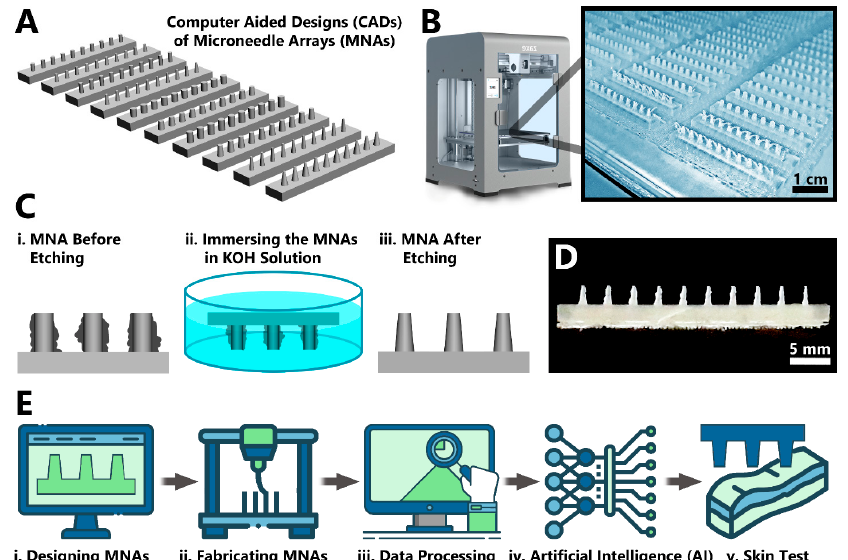
Figure 1. Fabrication of MNAs using 3D printing and features enhancement using chemical